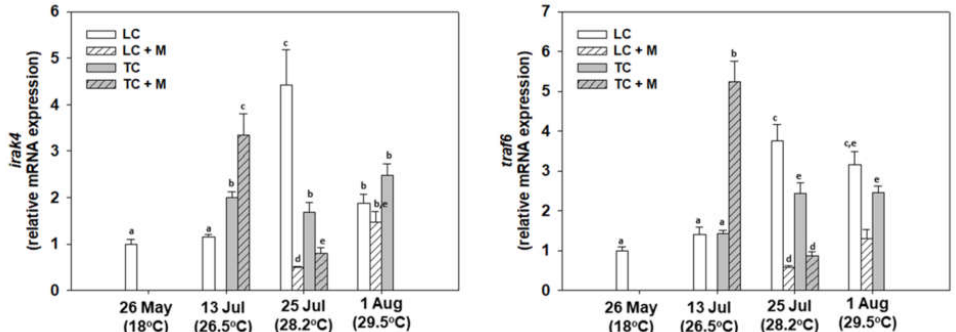
Figure 10. Relative irak4 and traf6 mRNA expression levels in the mantle of M. galloprovincialis specimens, either infected by Martelia spp. (M) or not. Samples were collected from Thermaikos Gulf during a summer heatwave both from traditional culture-Bouchot (TC) and long-line system (LC). Values represent means ± SD; n = 5 preparations from different animals. Lower case letters indicate statistically significant differences ( p < 0.05) between samples.